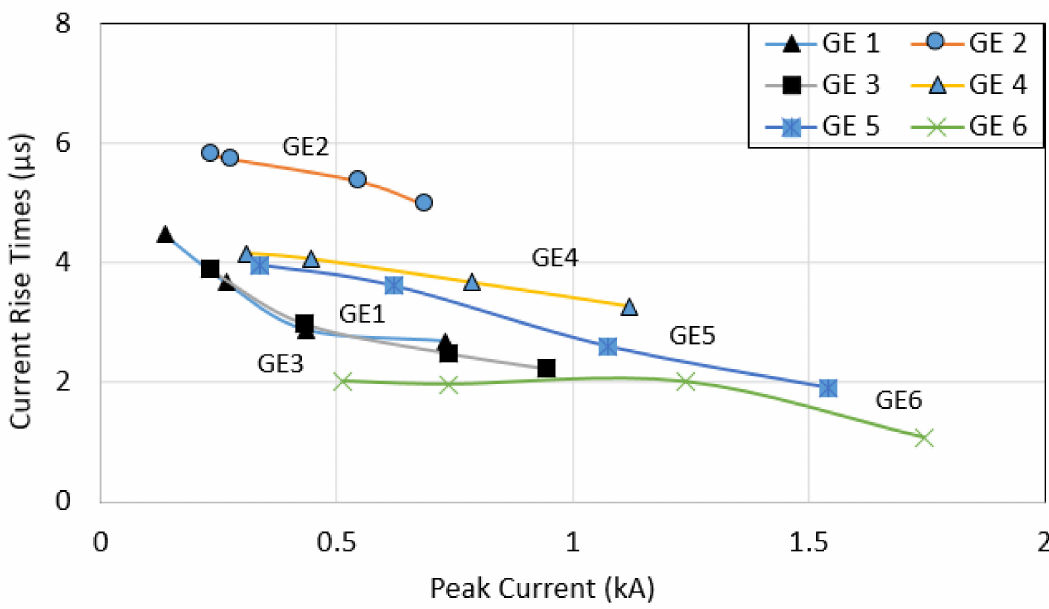
Figure 4. Current rise times for GEs at various peak current magnitudes under positive impulse polarity.